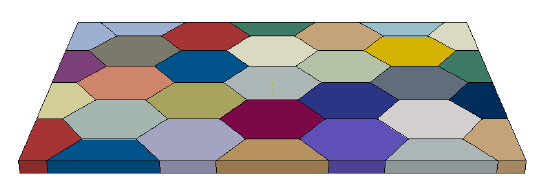
Figure 3. 3D polycrystal crystal plasticity simulation including gradient effects where each color represents a different grain orientation.